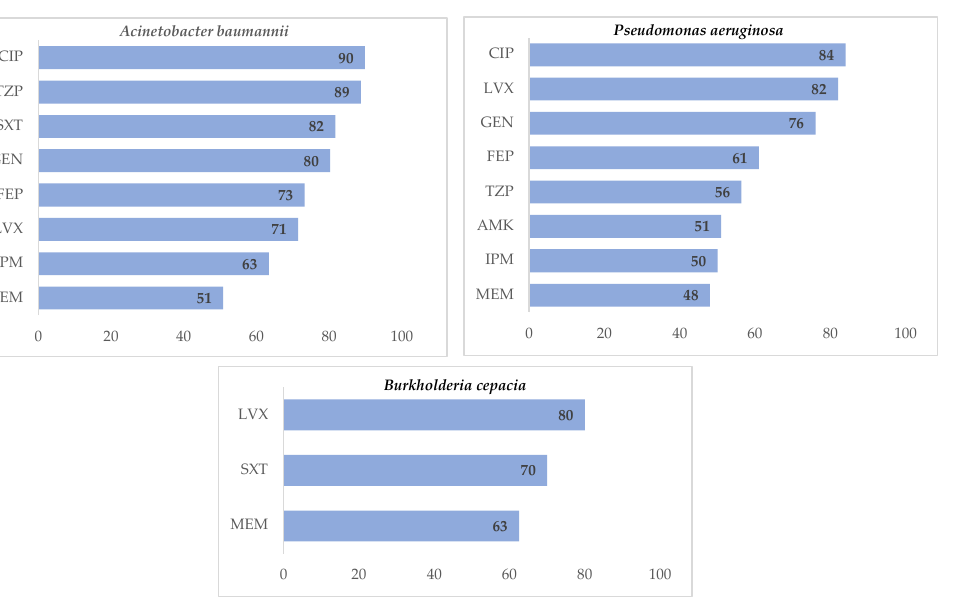
Figure 3. Antimicrobial resistance patterns in non-Enterobacteriaceae isolates at Yangon General Hospital, Myanmar, in 2018. X-axis represents the percentage of resistance. AMK = Amikacin, CIP = Ciprofloxacin, FEP = Cefepime, GEN = Gentamicin, IPM = Imipenem, LVX = Levofloxacin, MEM = Meropenem, SXT = Trimethoprim/Sulfamethoxazole, TZP = Piperacillin/Tazobactam.